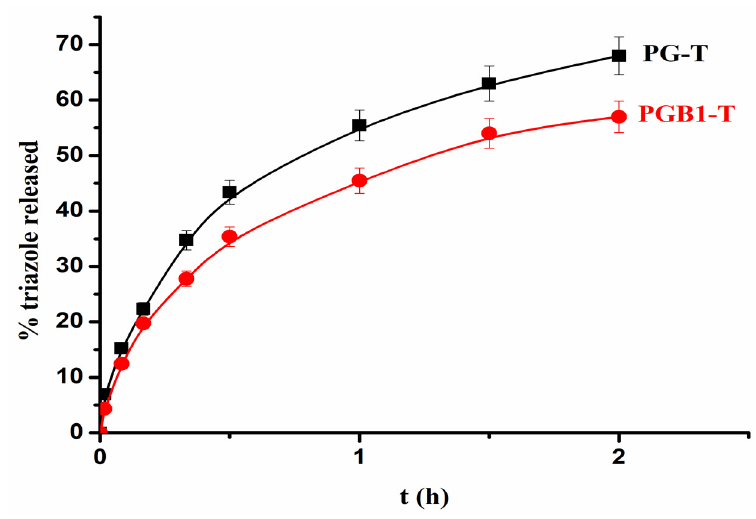
Figure 14. Release profiles of 1,2,4-triazole from PG-T and PGB1-T systems at pH = 1.2.